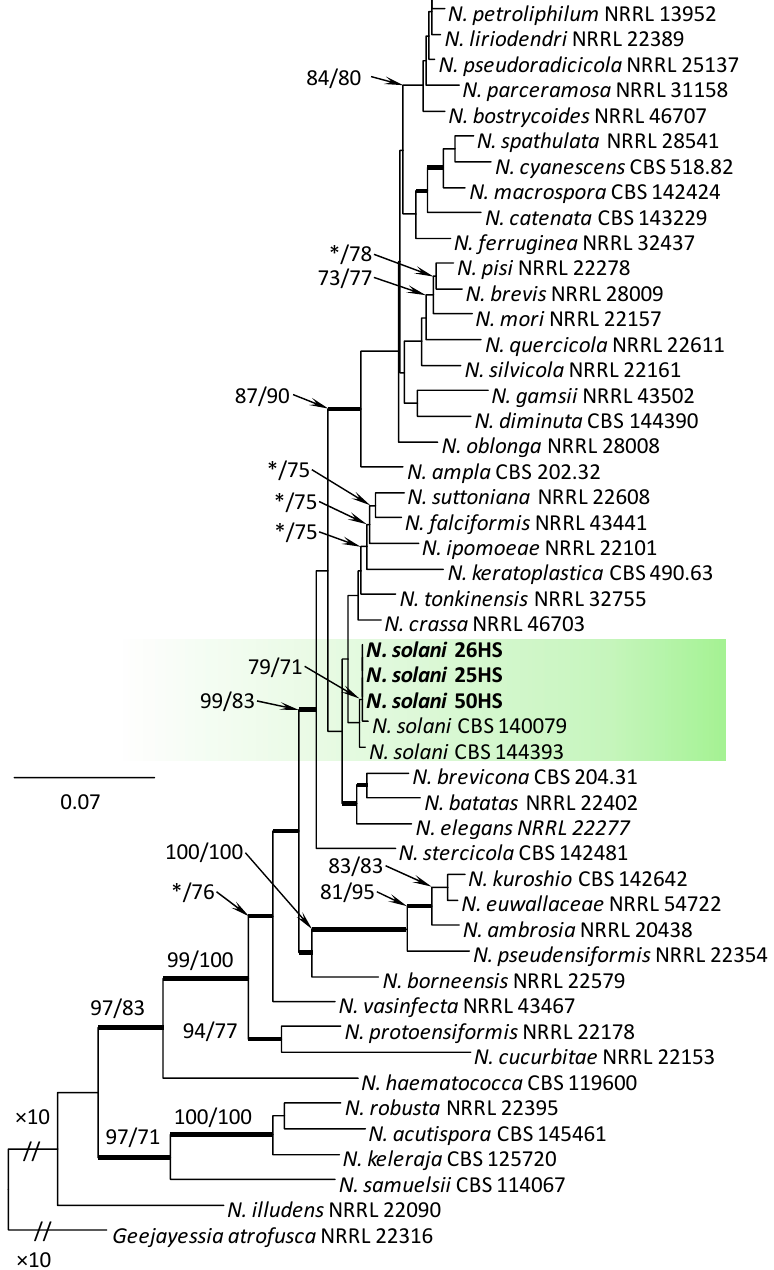
Figure 5. Phylogram obtained from Maximum Likelihood (ML) analysis of the combined dataset of RPB2 + TEF1- α for selected species of Neocosmospora spp. Sequences obtained during this study are presented in bold font. The Bootstrap values ≥ 75% for ML and Maximum Parsimony (MP) analyses are presented at nodes as follows: ML/MP. Bold branches indicate posterior probabilities values ≥ 0.95 obtained from Bayesian Inference (BI) analyses. * Bootstrap values <75%. The tree is drawn to scale (see bar) with branch length measured in the number of substitutions per site.